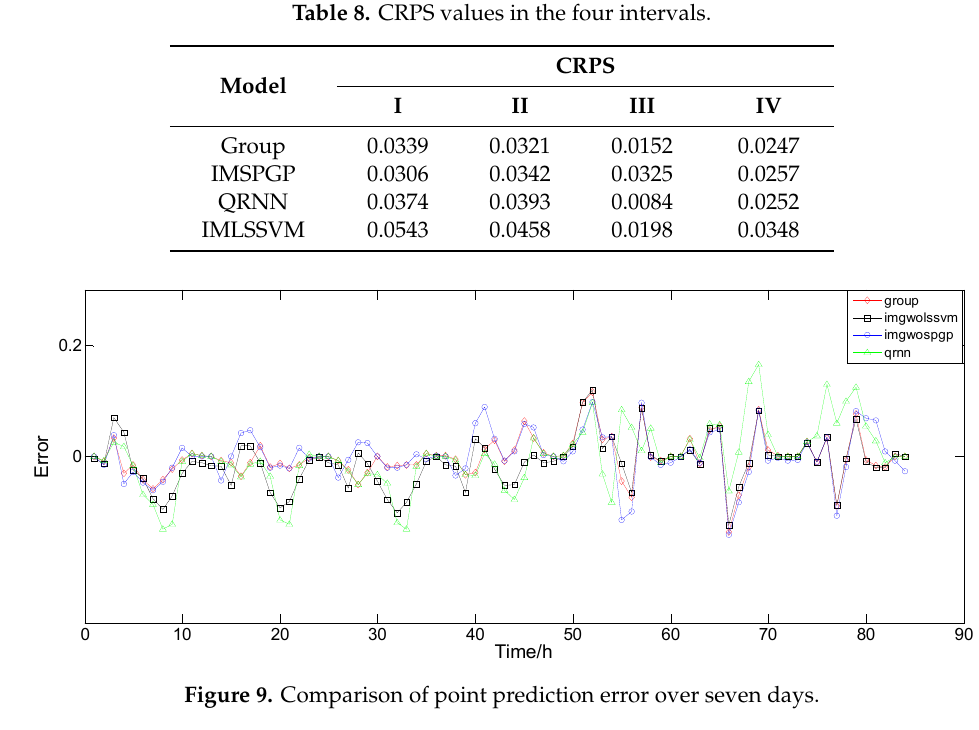
Table 8. CRPS values in the four intervals.